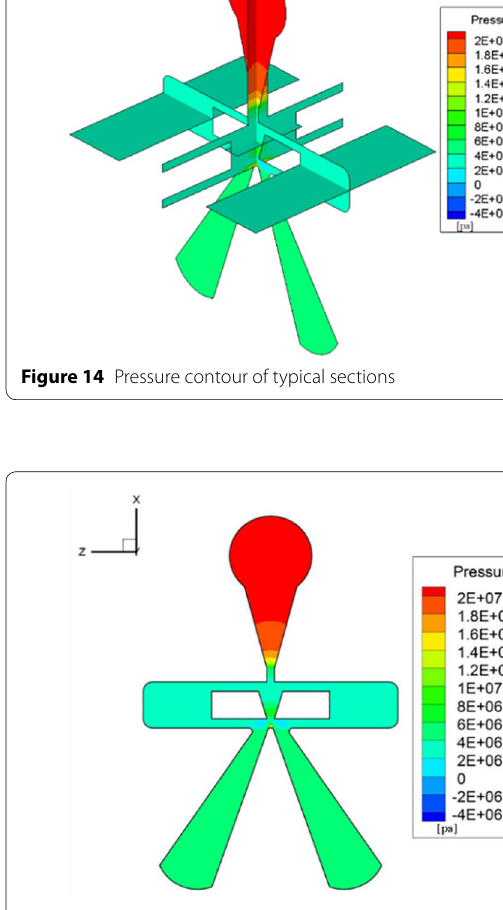
Figure 15 Pressure contour of the central